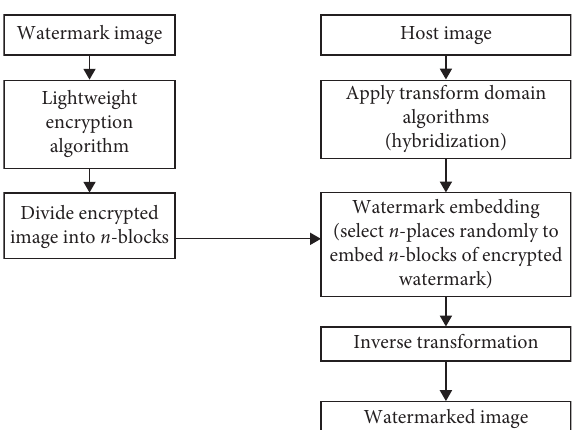
Figure 2: Framework of hybrid methods of digital image water- mark embedding.